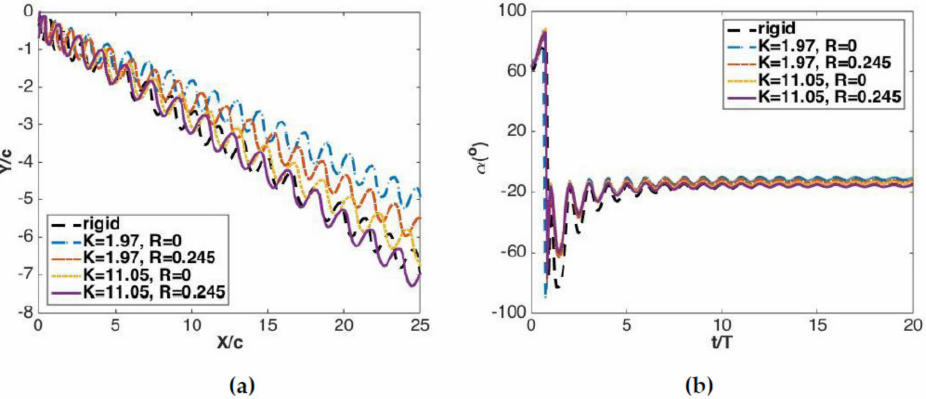
Figure 5. ( a ) Trajectory of the entire system tracked by the location of the active joint. ( b ) Orientation angle of the motion trace ( α =